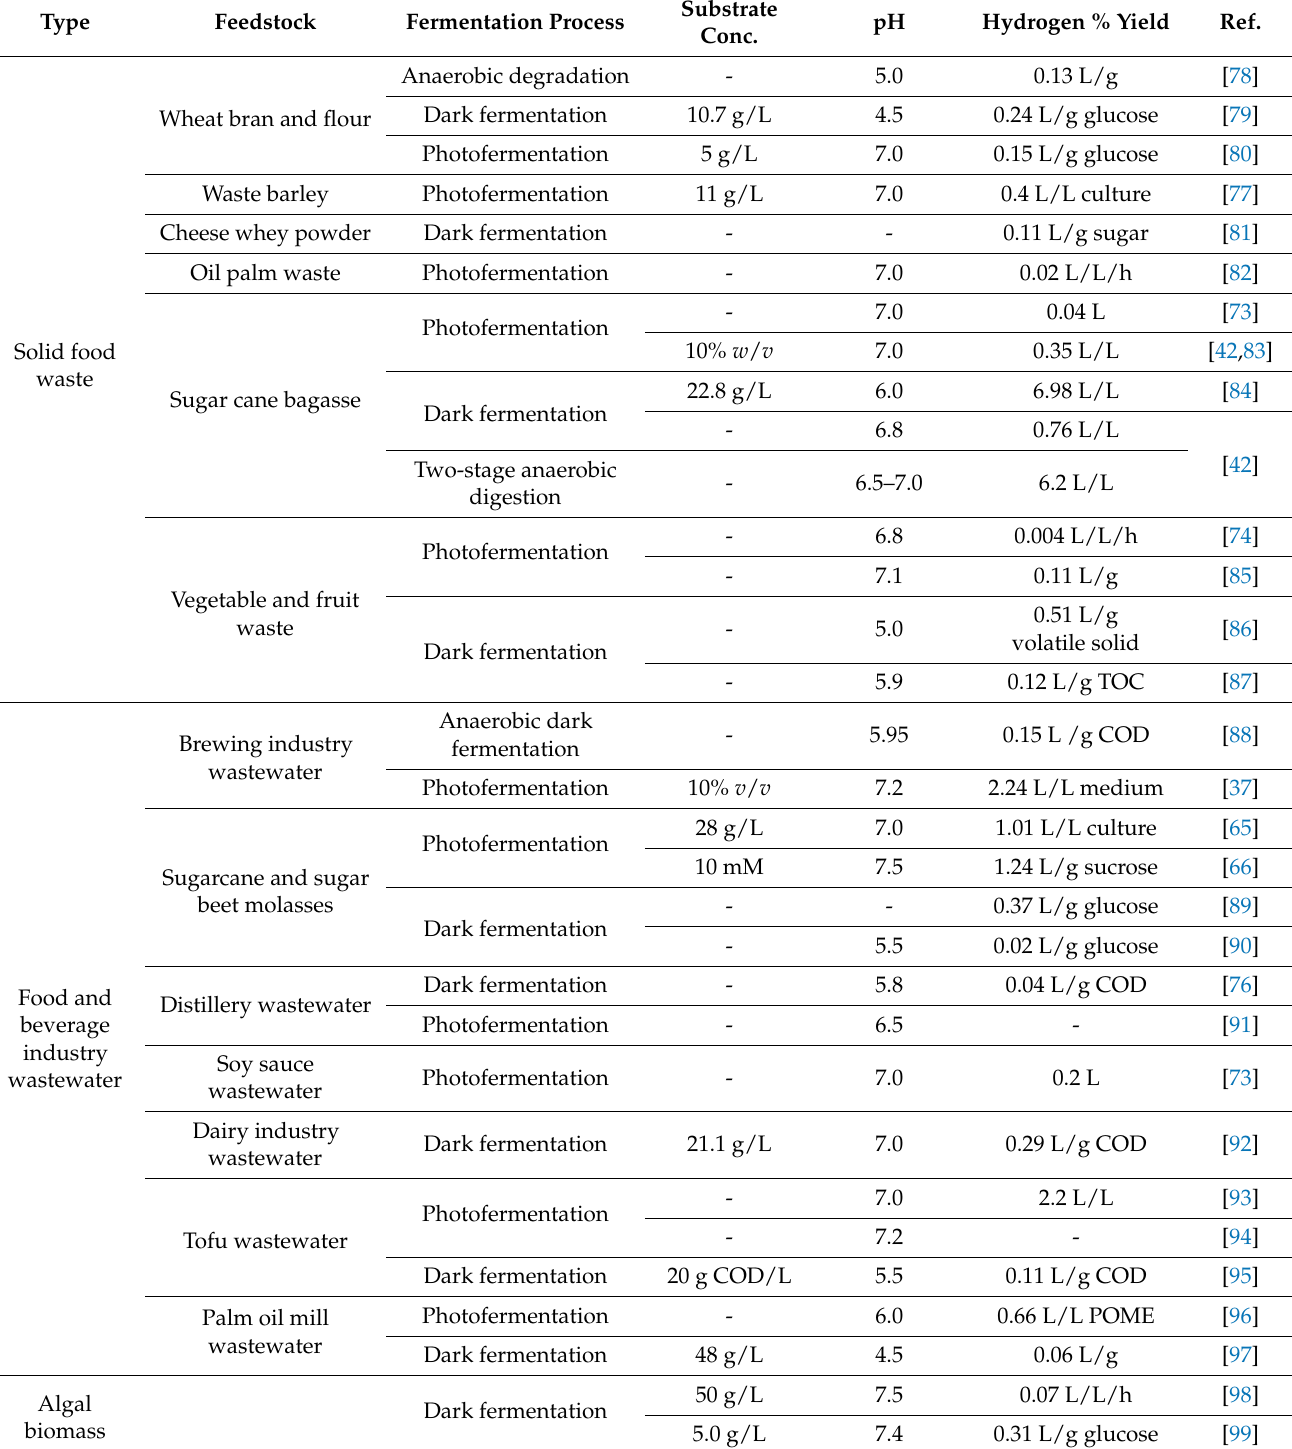
Table 1. Utilization of different feedstocks for hydrogen